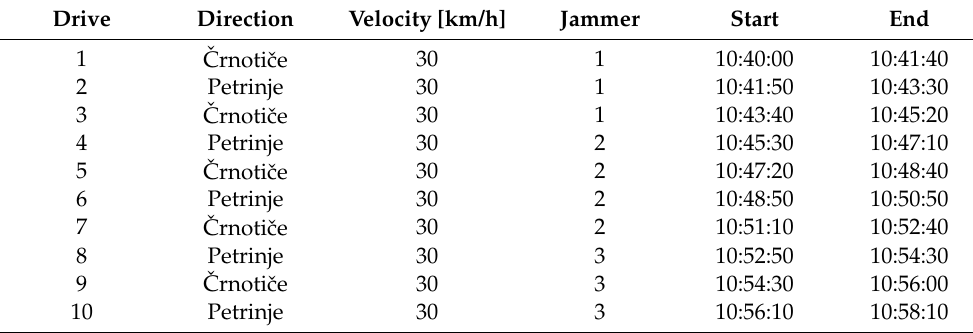
Table 8. Times of drives with different jammers (1, 2, 3); Session 3 of DOY